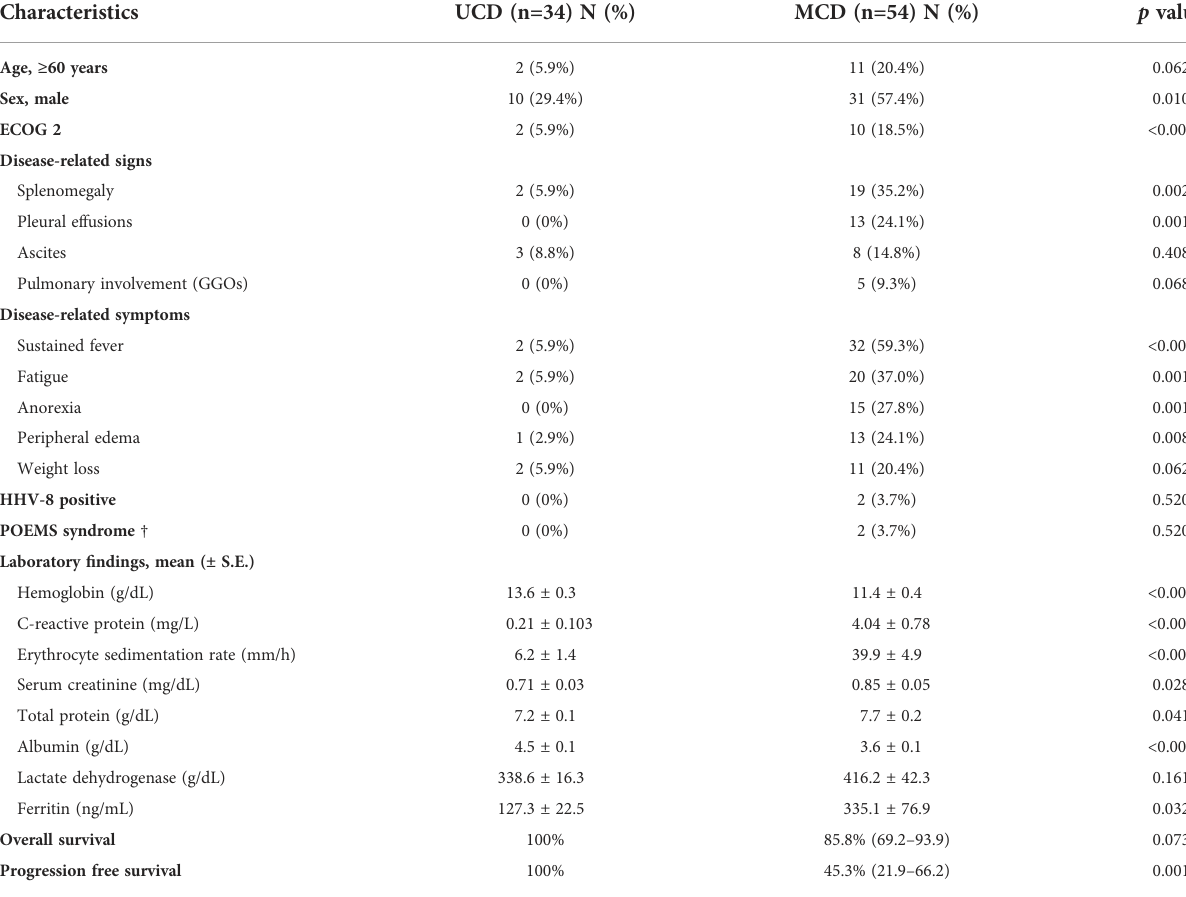
TABLE 2 Comparison of clinical characteristics and survival outcomes between patients with UCD and MCD.